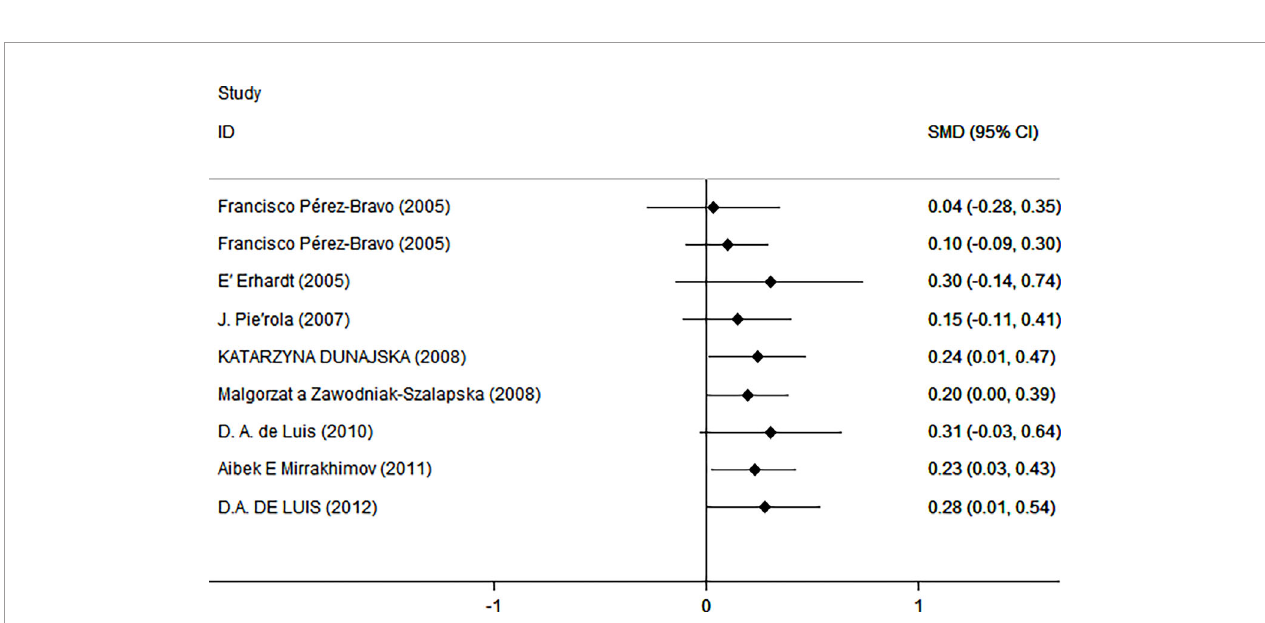
FIGURE 6 | Cumulative analysis.